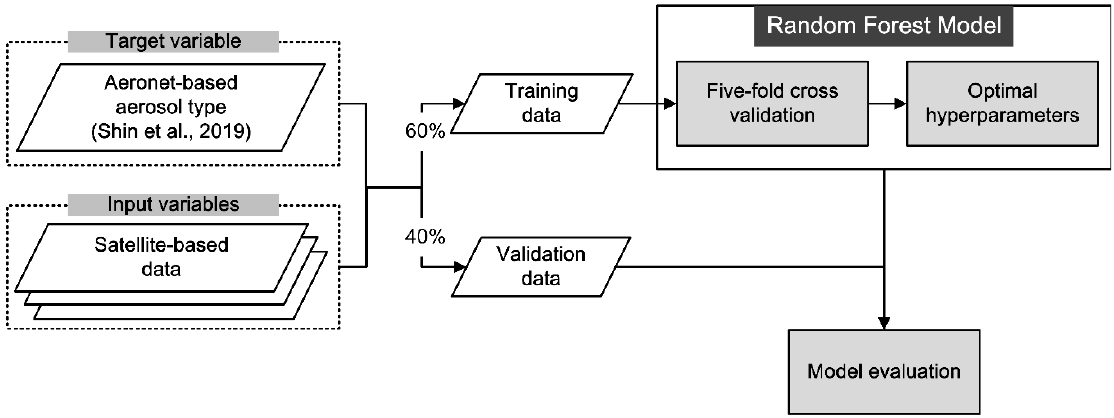
Figure 1. Schematic diagram of random forest (RF) aerosol classification model. Table 2. Threshold values used in classifying aerosol types using AERONET measurement data.